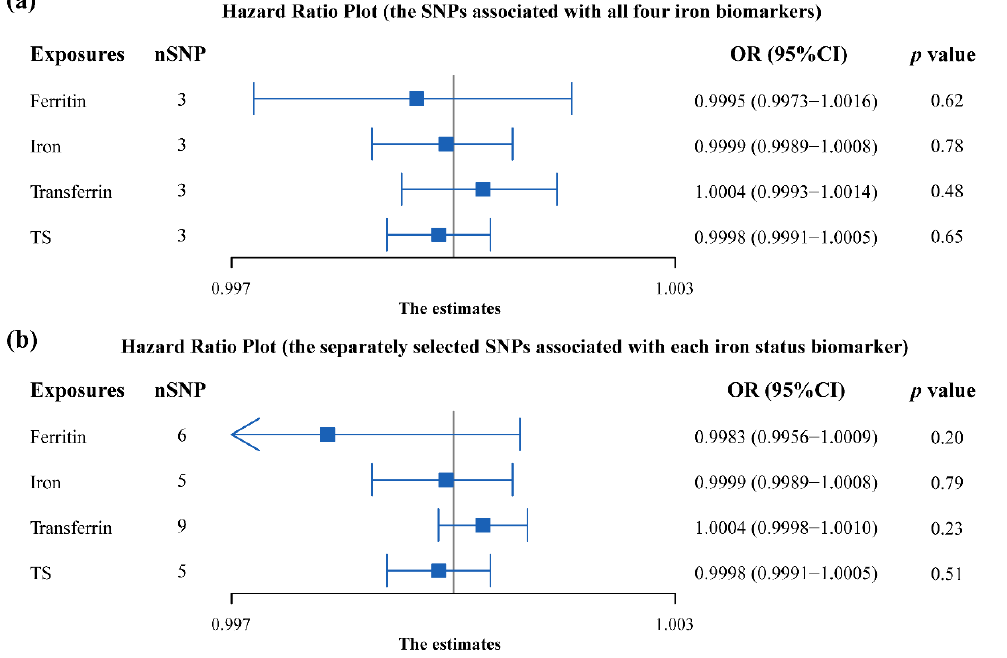
Figure 3. Forest plot summarising the overall Mendelian randomisation estimates of SNP specific- ity and the causal effect on heart failure. ( a ) Using three SNPs associated with all four iron bi- omarkers; ( b ) using separately selected SNPs associated with each iron status biomarker. OR — odds ratio; CI — confidence interval.